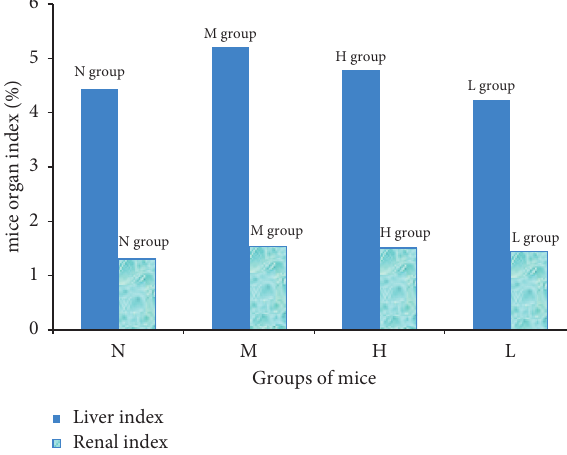
Figure 8: Organ index of KM mice in each